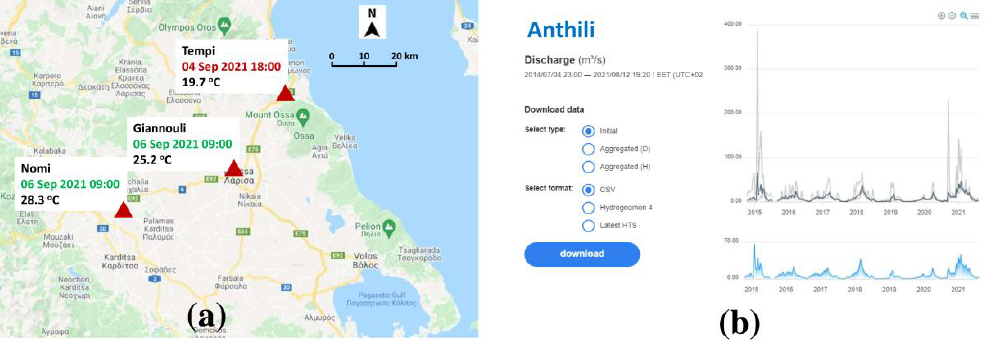
Figure 1. ( a ) Dynamic map for real-time observations. ( b ) Application for retrieval of raw and processed data.